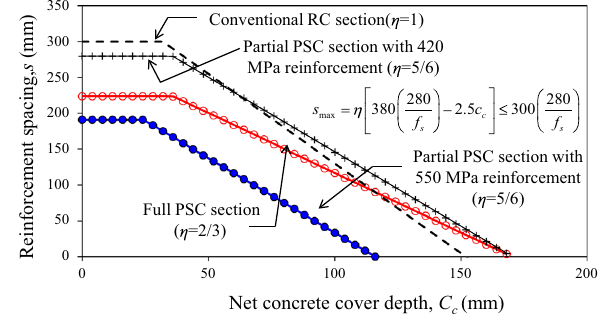
Fig. 13 Maximum allowable spacing of flexural